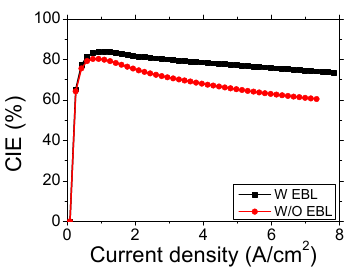
Figure 2. Measured CIE as a function of the injection current density for the samples with-EBL (black) and without-EBL (red) [78]. Courtesy of Prof. Song, J.H.